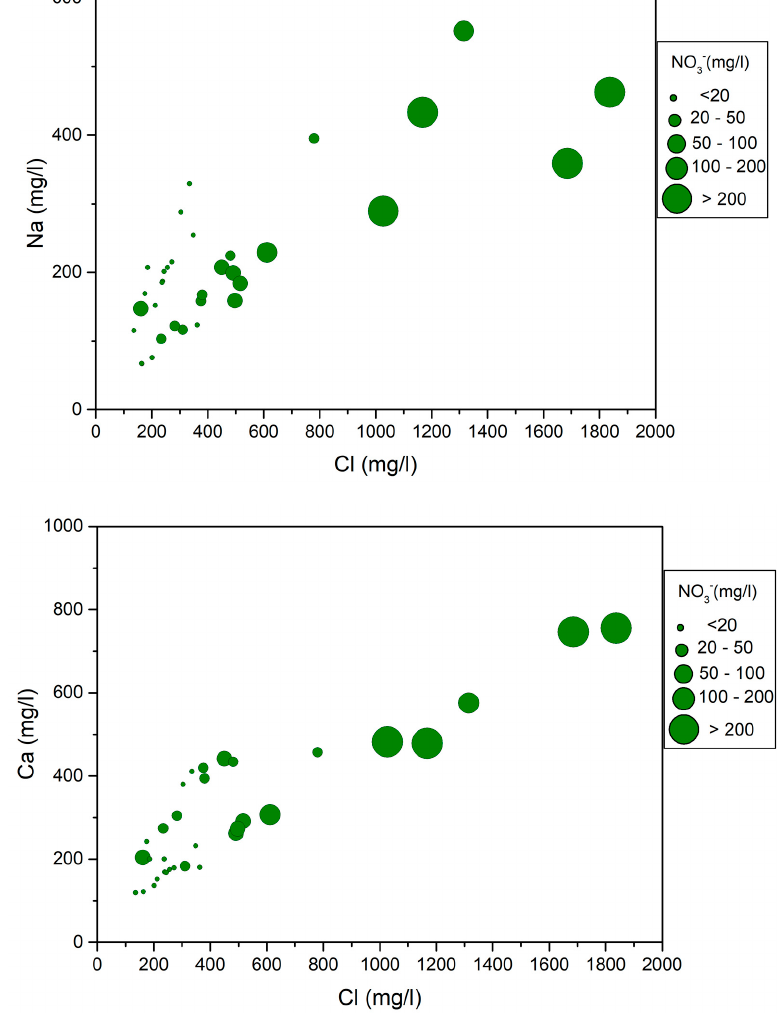
Figure 11. Positive compositional correlation between NO 3 2 − and Cl − , Ca 2 + , and Na − in Wasia groundwater in the Al Kharj area.